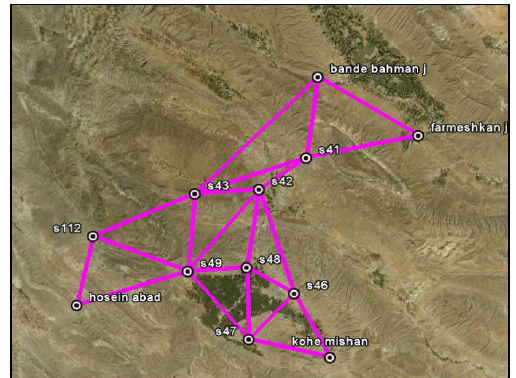
Fig 2- Triangular and Static method for georefrencing the satellite images